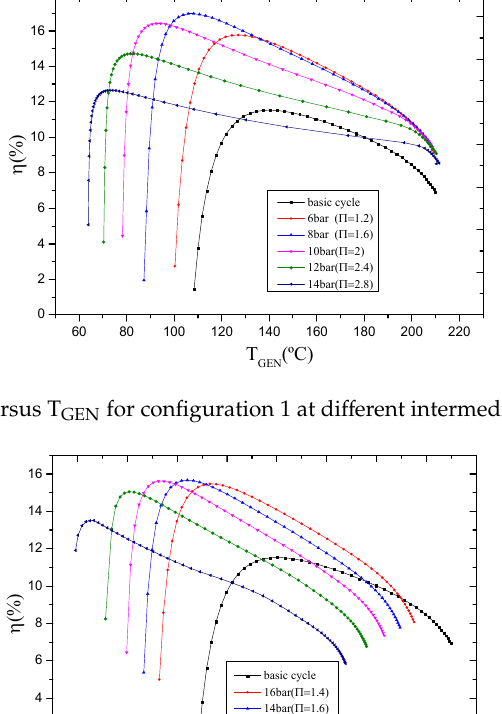
Figure 14. η versus T GEN for configuration 2 at different intermediate pressures.